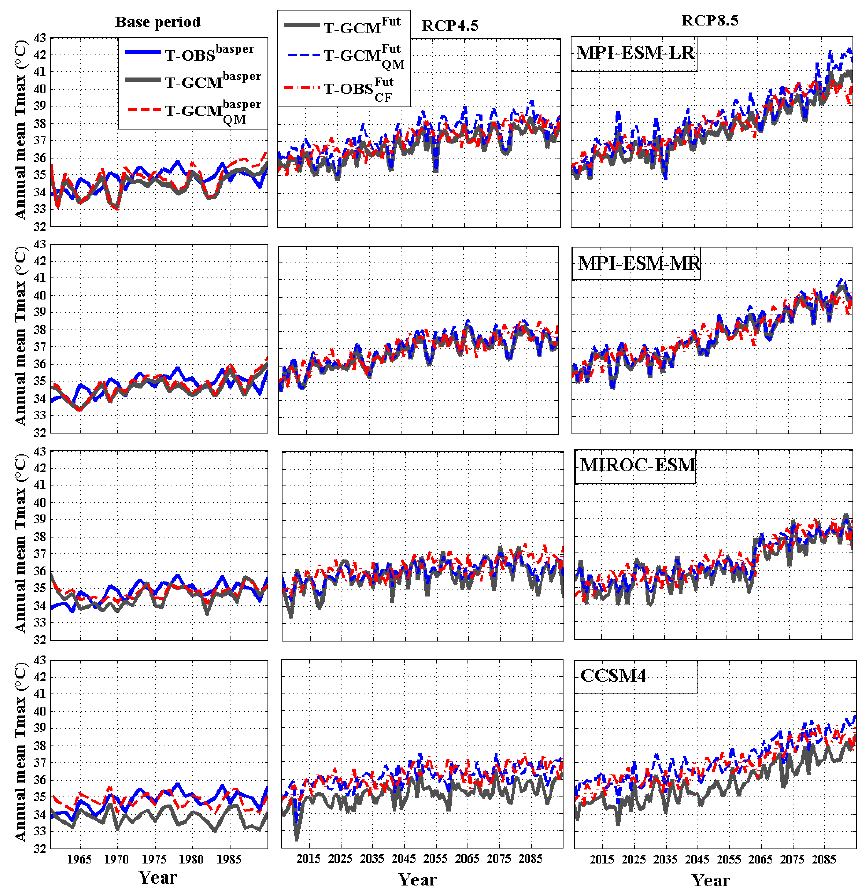
Figure 7. Comparison between the annual T max data observed for the DRB and the results provided by the four GCM models, before (grey line) and after (dashed line) applying the QM approach (the CF method is added for the future climate): the Base period; and future climate (for RCP4.5 and